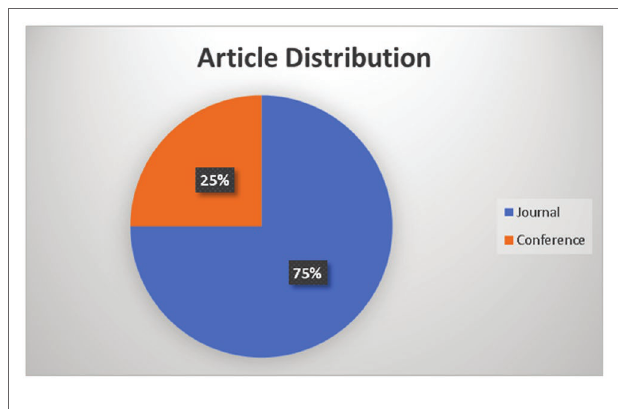
FIGURE 5 | Article distribution. TABLE 2 | AI method usage with operational excellence.